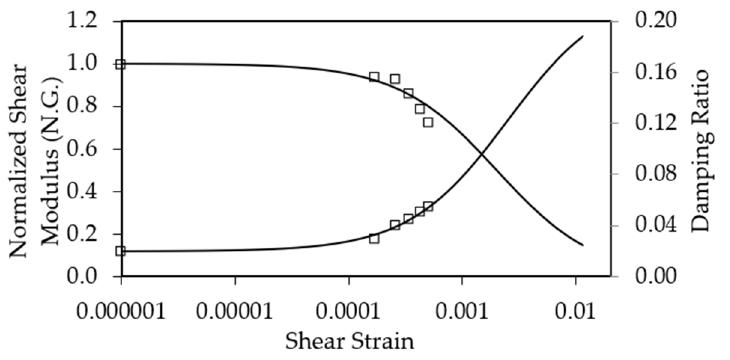
Figure 4. Illustration of hyperbolic models (Equation (1)) fitted to normalized shear modulus (N.G.) and damping ratio (sample SB, Confinement ( σ ) = 40 kPa).